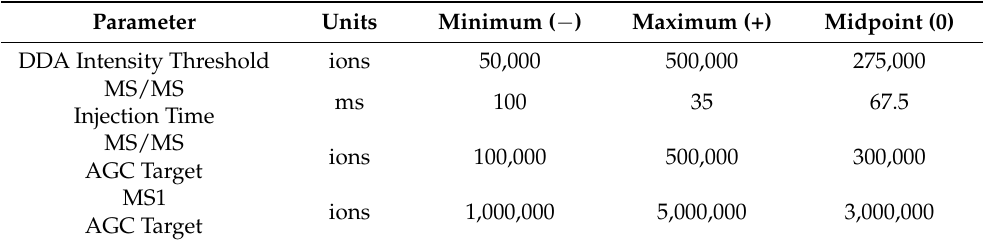
Table 4. Maximum, minimum, and midpoint values used for each of the MS parameters in the screening DOE